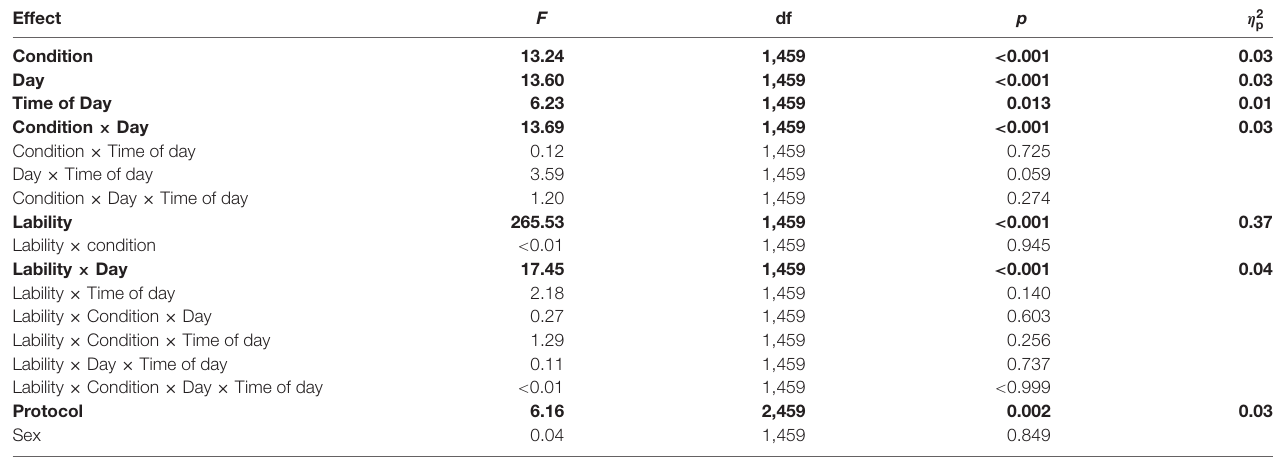
TABLE 5 | Mixed-effects ANOVA for frequency of NSSCR with lability classification.